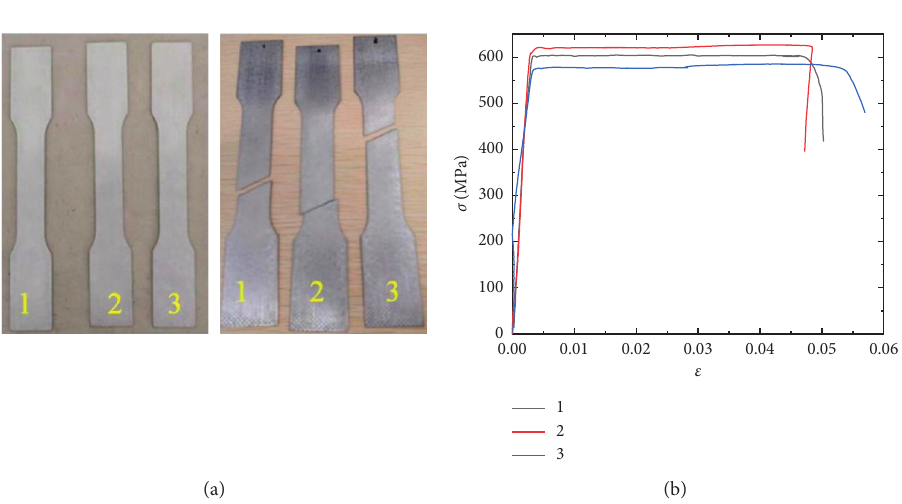
Figure 4: Coupon tests. (a) Tension coupons and failure modes of coupons. (b) Stress-strain curves of tension coupons.